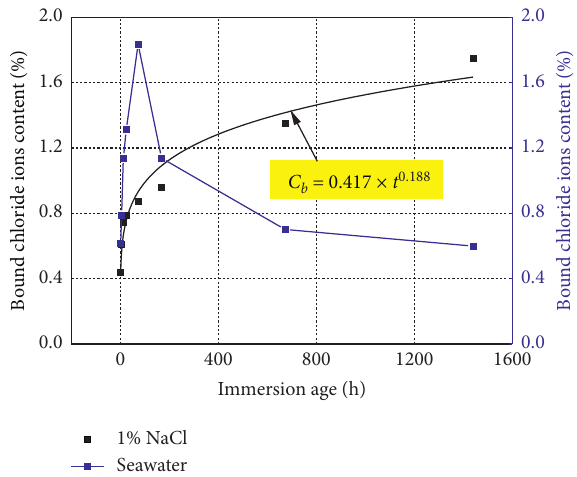
Figure 13: The bound chloride ions content of concrete powder with immersion